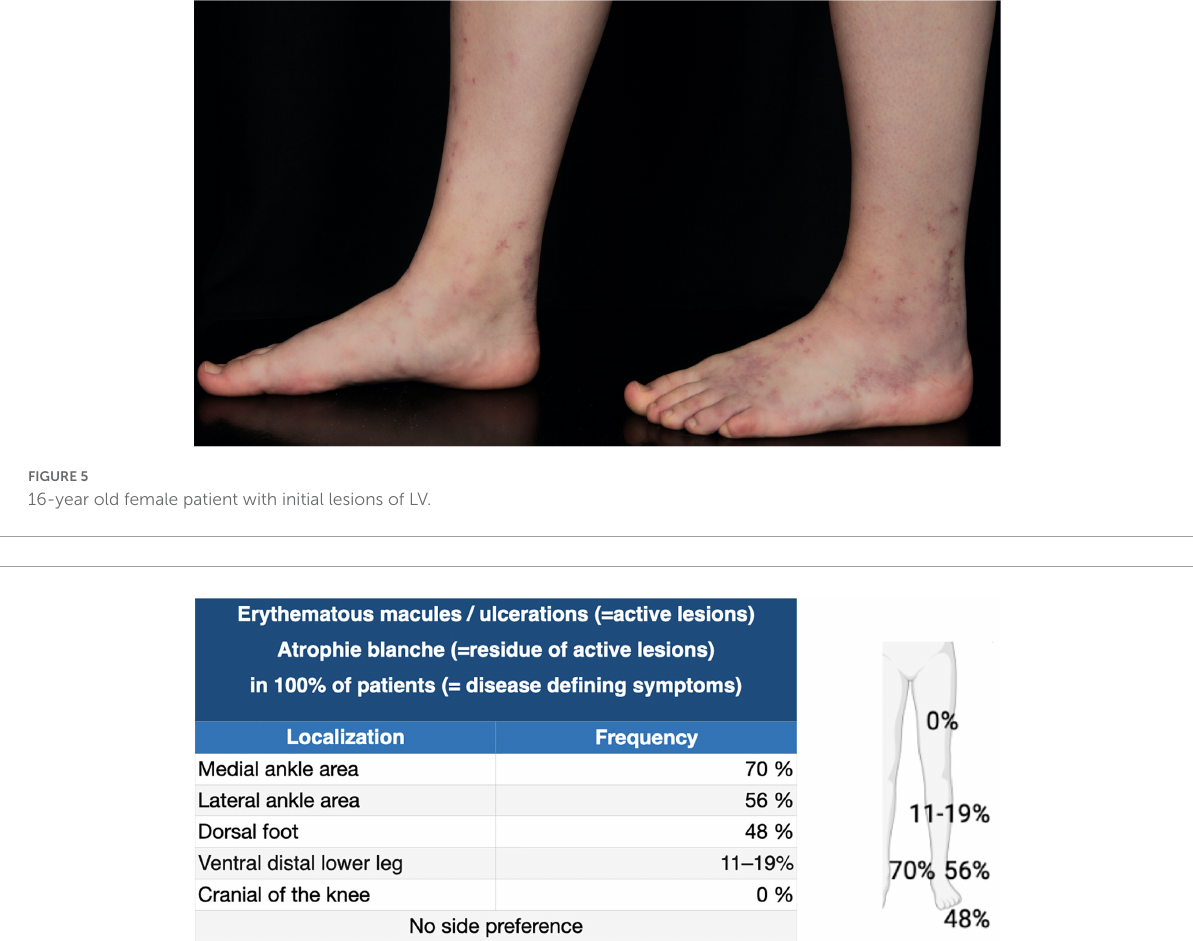
of capillaries in the upper dermis (45). Lesions of LV are